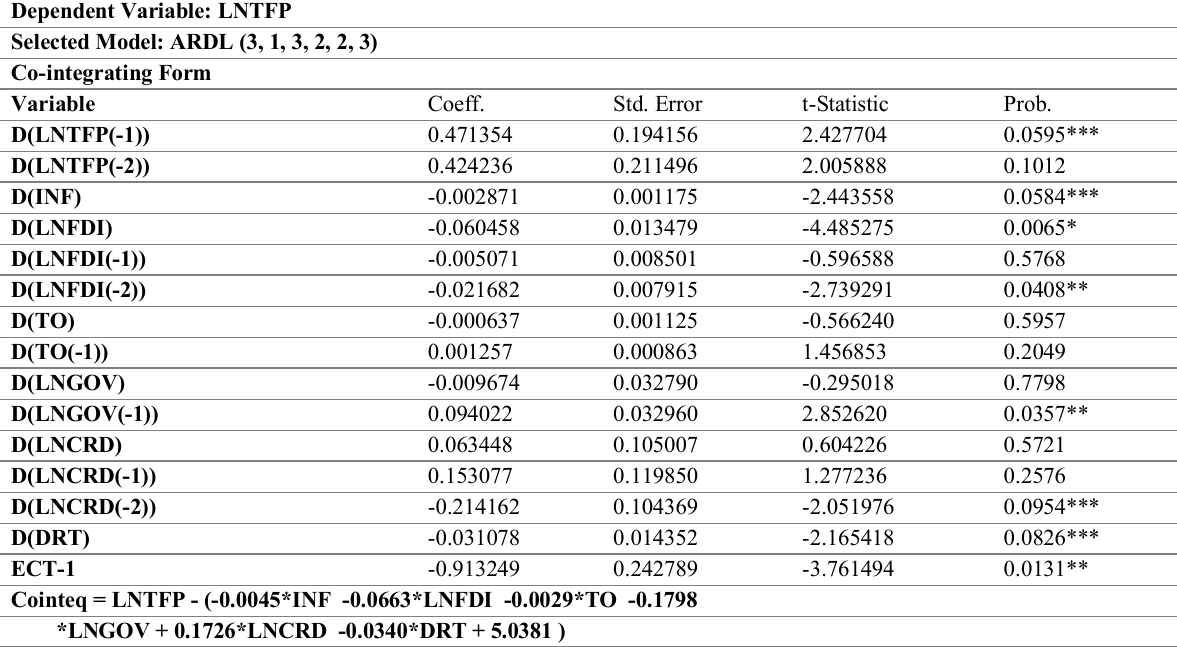
Table 6: Short run coefficients